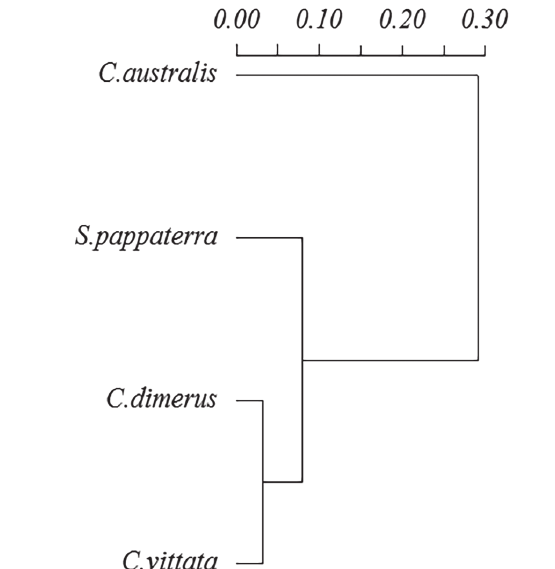
Fig. 3. Dendrogram of Bray-Curtis dissimilarity for the trophic matrix (percentage of IAi of the food resources versus species) and morphologic matrix (RHM, SRGR, NGR, PM, RWM, DRG, OM versus species) of the cichlids of the Cuiabá River basin, Mato Grosso, Brazil. IAi = Feeding Index; RHM = Relative height of the mouth; SRGR = Relative size of the gill rakers; NGR = Number of gill rakers; PM = Protrusion of the mouth; RWM = Relative width of the mouth; DRG = Distance between gill rakers; OM = Orientation of the mouth. C. australis = Chaetobranchopsis australis; C. dimerus = Cichlasoma dimerus; C. vittata = Crenicichla vittata; S. pappaterra = Satanoperca